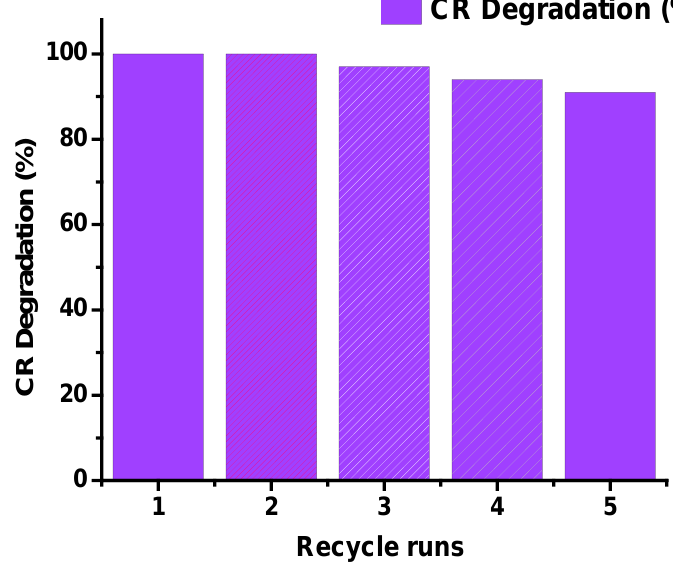
Figure 9. Reusability of Cu-ZnO/TiO 2 (CZT-2) nanocomposite photocatalyst for CR degradation (reaction conditions: CR dye = 75 mg/L, catalyst loading = 0.5 g/L, sunlight irradiation = 20 min).